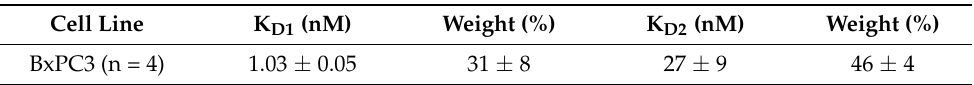
Table 1. Equilibrium dissociation constants (K D ) for the interaction of [ 99m Tc]Tc(CO) 3 -Ec1–LoPE with EpCAM-expressing BxPC3 cells. The data are from four samples (n = 4).